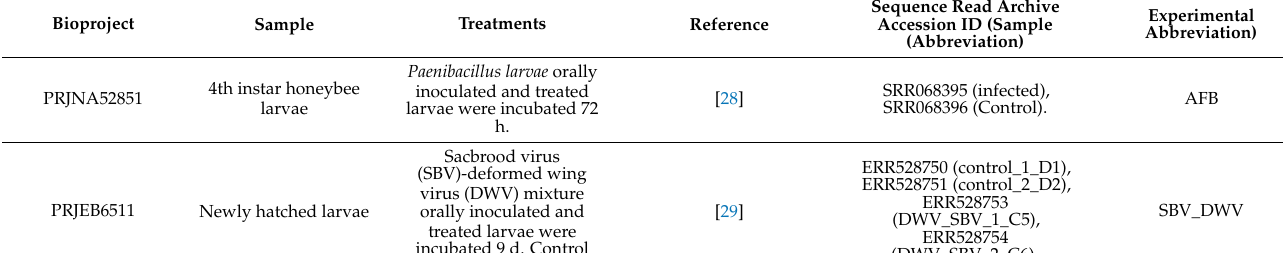
Table 2. Public RNA-Seq data used in expression